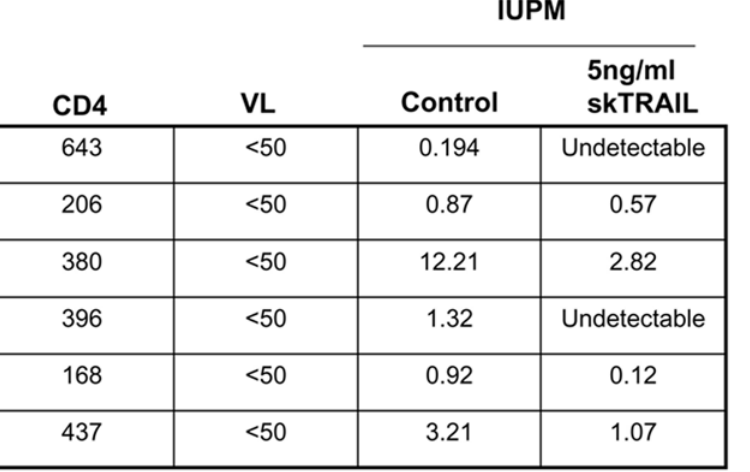
Figure 4. Superkiller TRAIL decreases HIV viral burden in PBLs from HIV infected individuals. PBLs from HIV infected individuals were isolated and treated with skTRAIL or BSA in a limiting dilution micro co-culture. HIV viral burden is reported as infectious units per million.